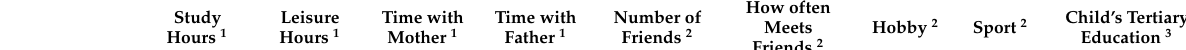
Table 4. Generalised structural equation model (GSEM) on young people’s time use and educational achievement. FTUS 1979, boys aged 10–18. First step models testing for sons’ time use and social connectedness in 1979, n = 366. Full model tested for education achieved by 40, n = 337.